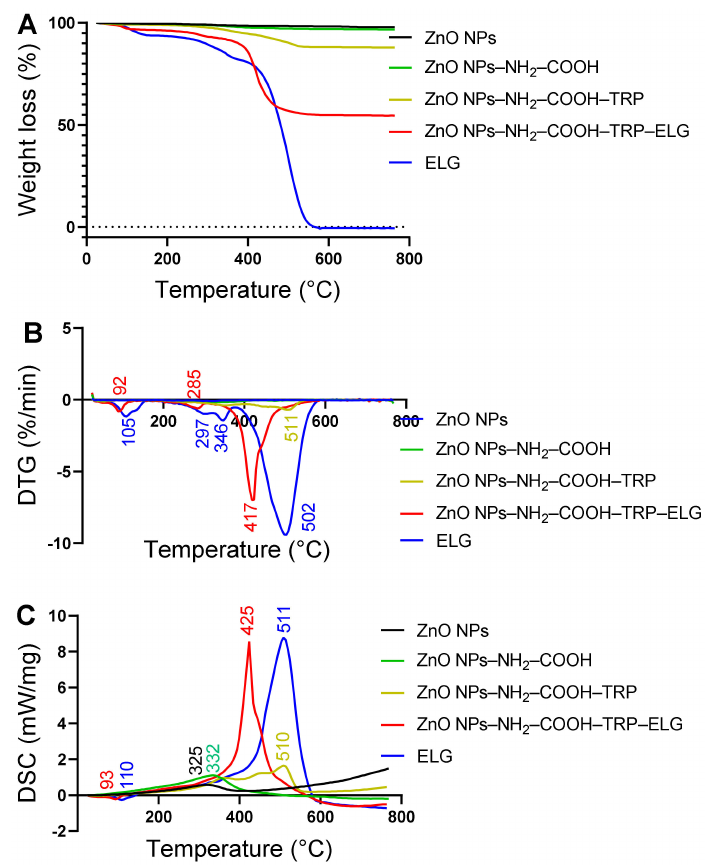
Figure 7. Thermal properties of materials at different stages, characterized using STA with DSC. ( A ) Weight loss measurements of all materials using STA. ( B ) DTG thermograms of all materials. ( C ) DSC analysis of all